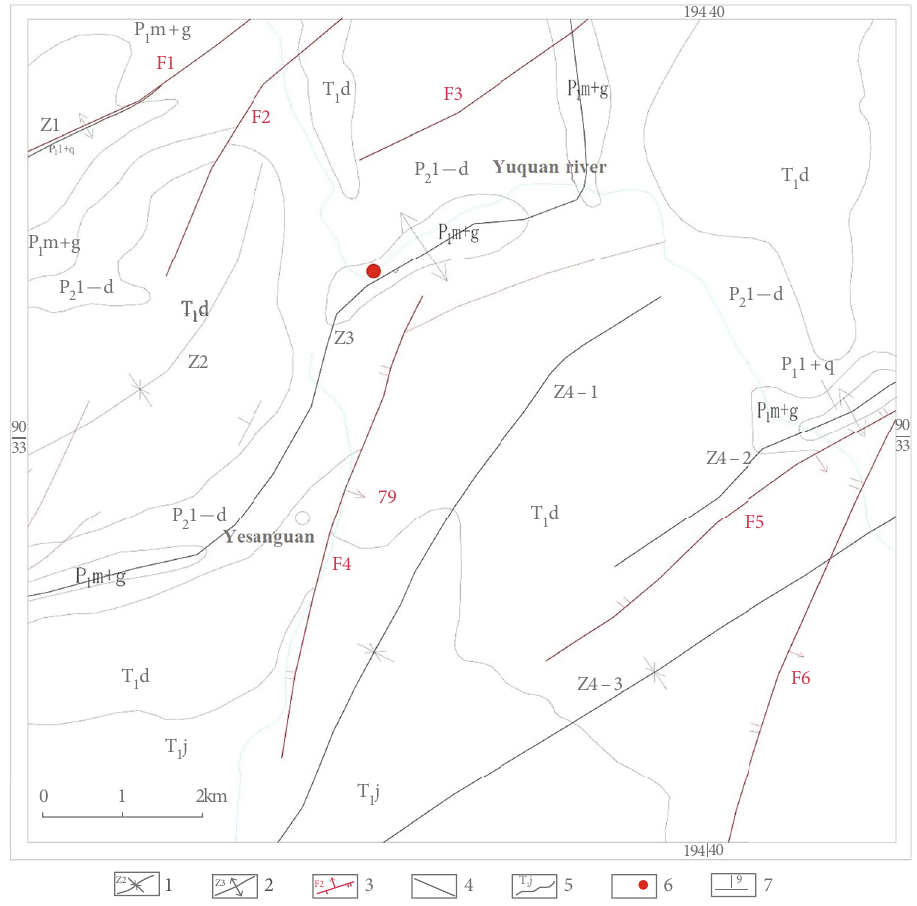
Figure 2: Outline map of geological structure of exploration area. 1, syncline and number; 2, anticline and number; 3, compressional torsional fault and its number; 4, general fault; 5, stratum code and boundary; 6, study area; 7,